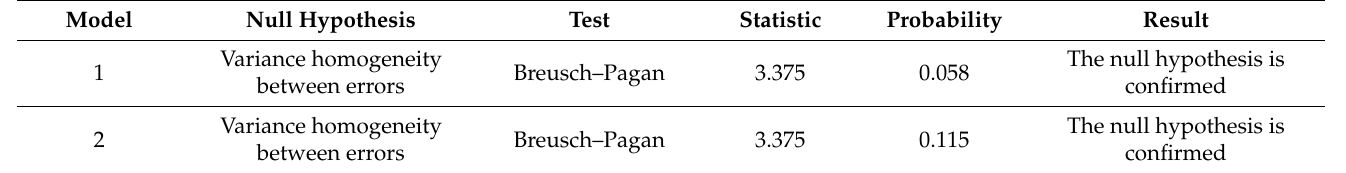
Table 6. The results of the Breusch–Pagan test to diagnose the homogeneity of variance of